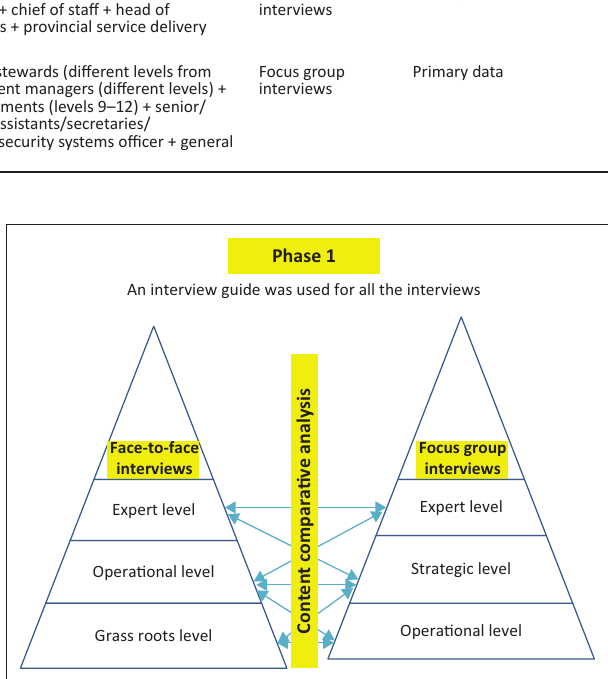
FIGURE 5: Content comparative analysis